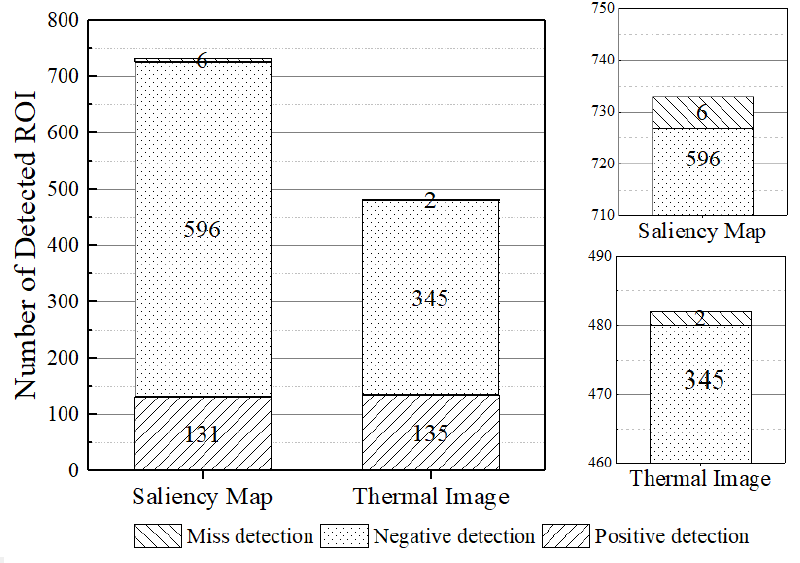
Figure 12. Number of positive, negative and missed detections for each segmentation